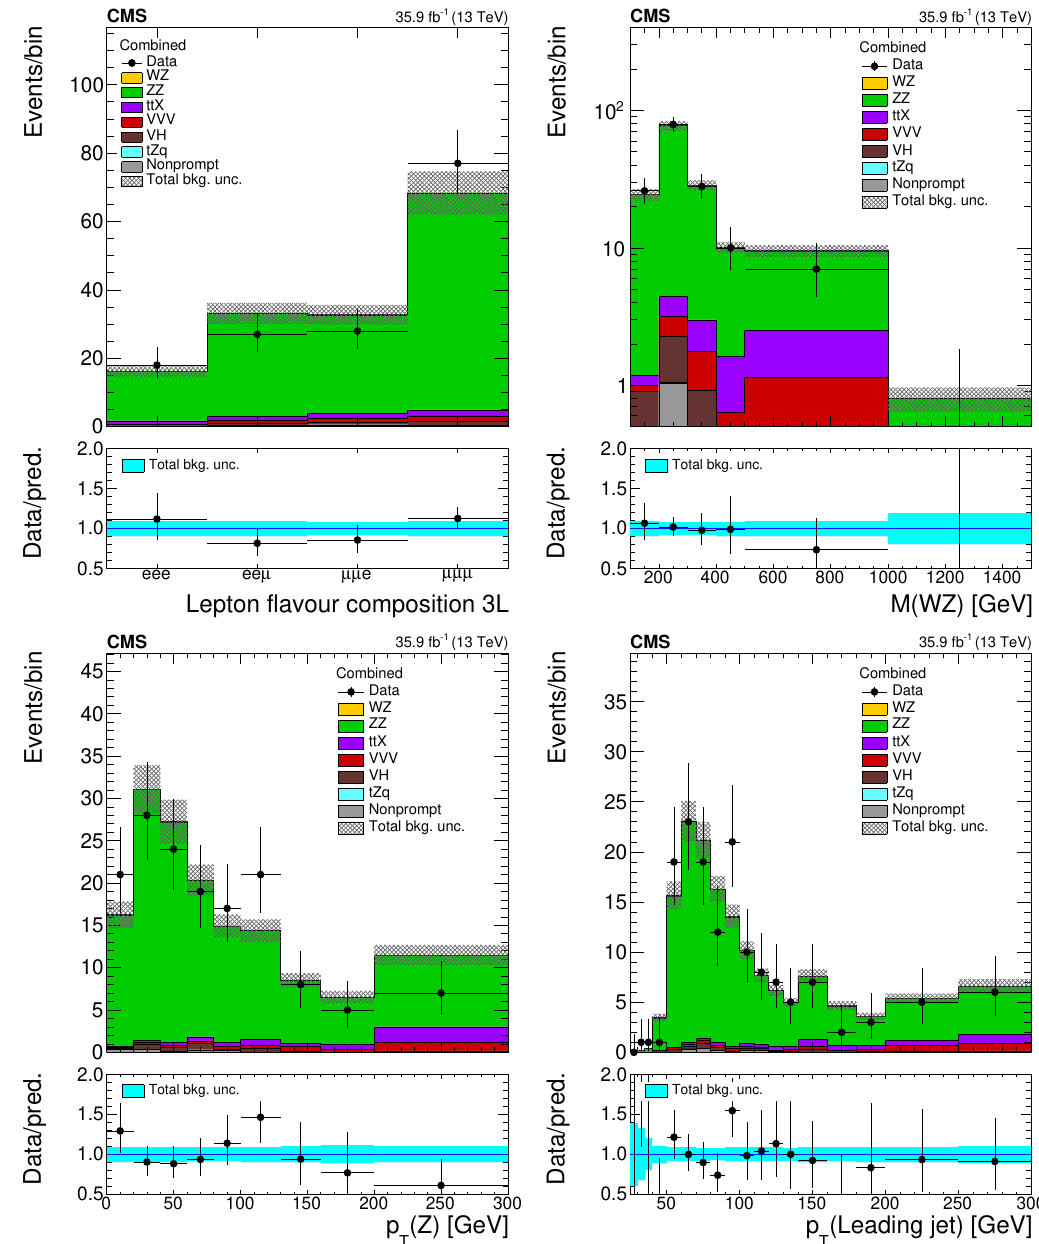
Figure 3 . Distribution of key observables in the ZZ control region de(cid:12)ned in table 1: (cid:13)avour composition of the three leading leptons (top left), invariant mass of the three leptons plus missing transverse momentum (top right), transverse momentum of the Z boson reconstructed from the p T of the two leptons assigned to it (bottom left), and transverse momentum of the leading jet (bottom right). Vertical bars on the data points include the statistical uncertainty and shaded bands over the prediction include the contributions of the di(cid:11)erent sources of uncertainty evaluated after the signal extraction